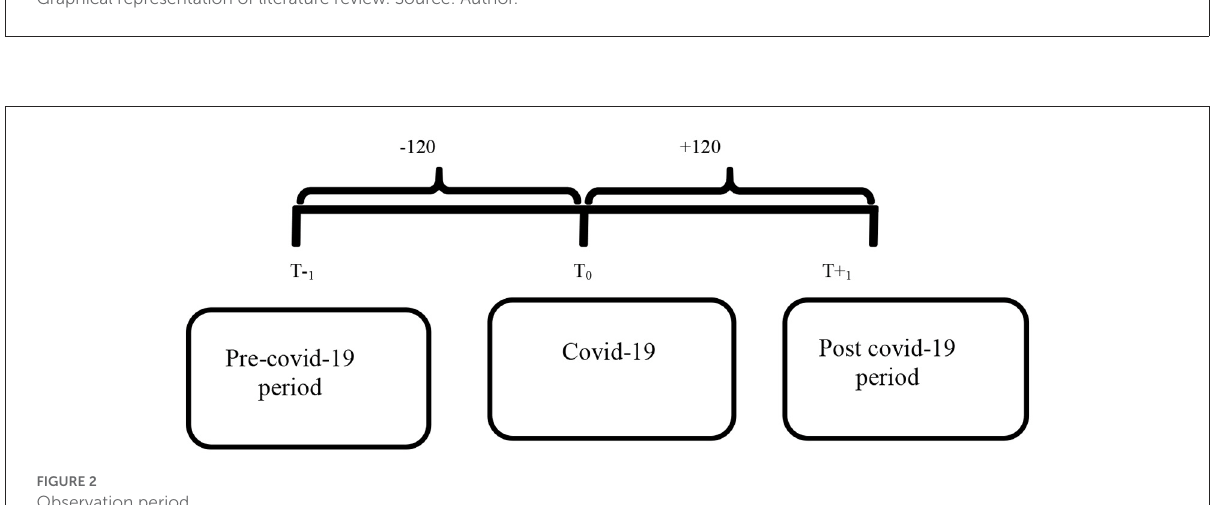
FIGURE2 Observation